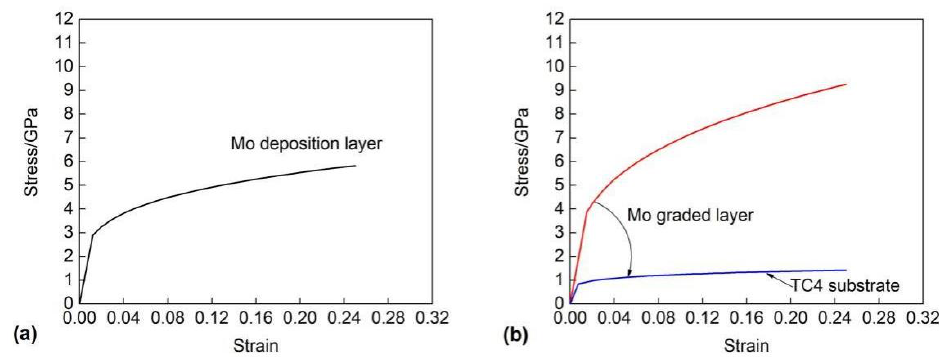
Figure 8. True stress-strain curves of ( a ) the Mo deposition layer and ( b ) the initial part of the Mo diffusion layer and the TC4 substrate. diffusion layer and the TC4